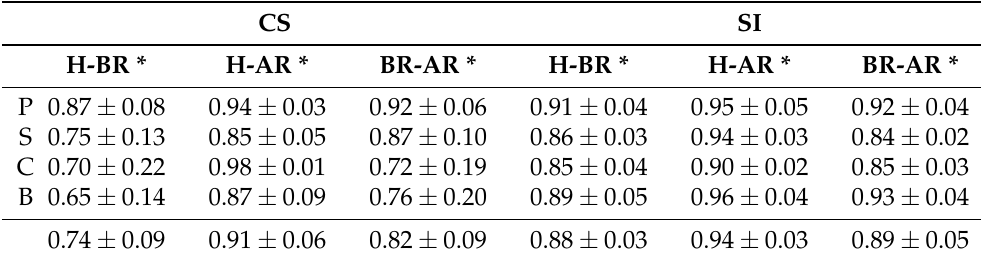
Figure 9. Comparison of the muscular synergies of the sound hand (in green) vs. the impaired hand (in the box) before (red) and after (blue) the rehabilitation treatment with the Gloreha robot for ball-grasping. Table 3. Summary table of comparisons among muscular synergy vectors for each exercise. P = pencil; S = sheet; C = cylinder; B = ball; * denotes statistical